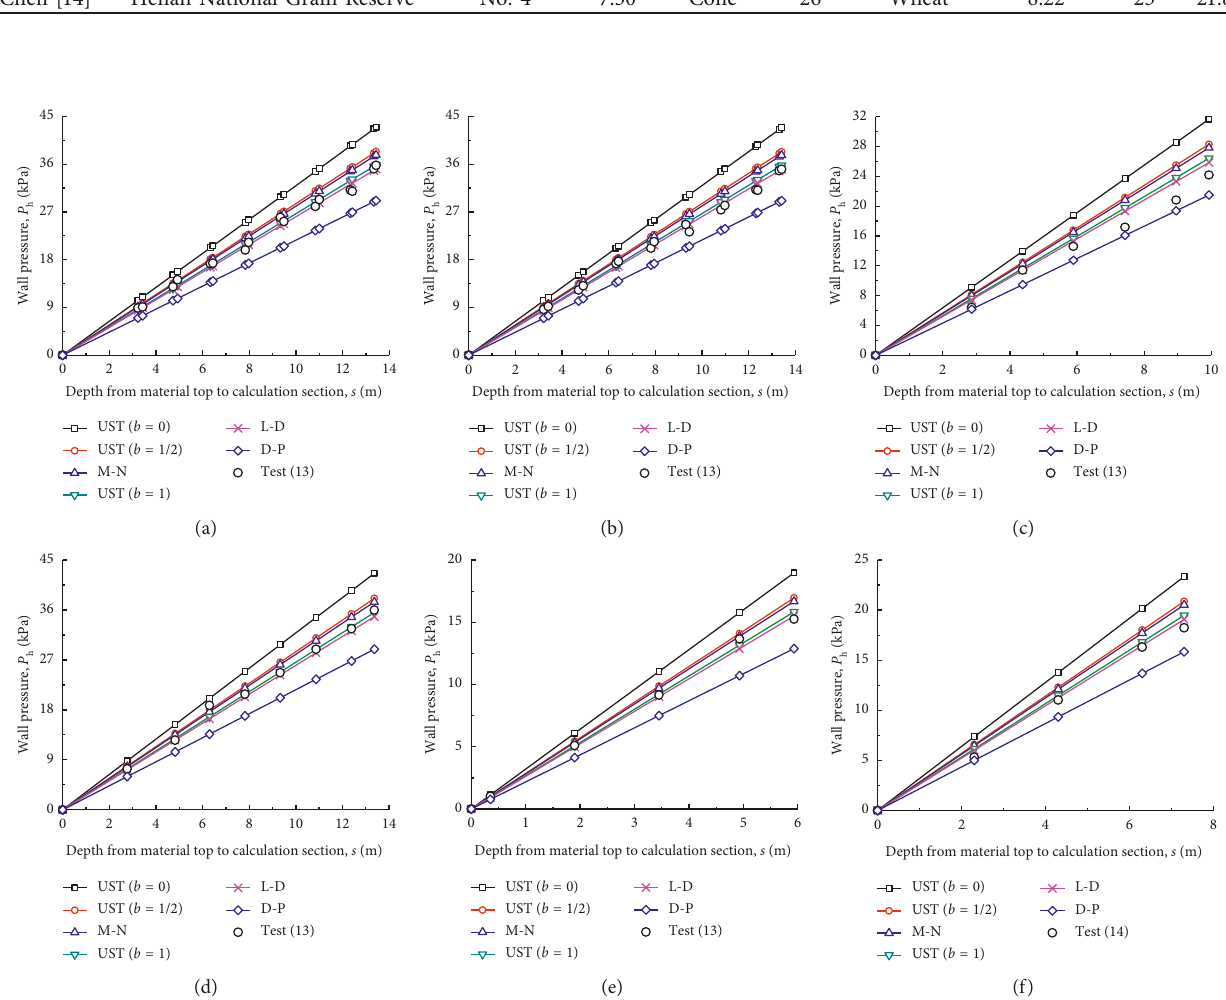
Figure 5: Comparisons of the results from six strength criteria with experimental data for squat silos (modified from Sun et al. [37]). (a) Experimental data of No. 4 silo for the first group from Yuan [13] (cone pile). (b) Experimental data of No. 4 silo for the second group from Yuan [13] (flat pile). (c) Experimental data of No. 7 silo for the first group from Yuan [13] (cone pile). (d) Experimental data of No. 7 silo for the second group from Yuan [13] (flat pile). (e) Experimental data of No. 8 silo for the first group from Yuan [13] (flat pile). (f) Experimental data of No. 4 silo for the first group from Chen [14] (cone